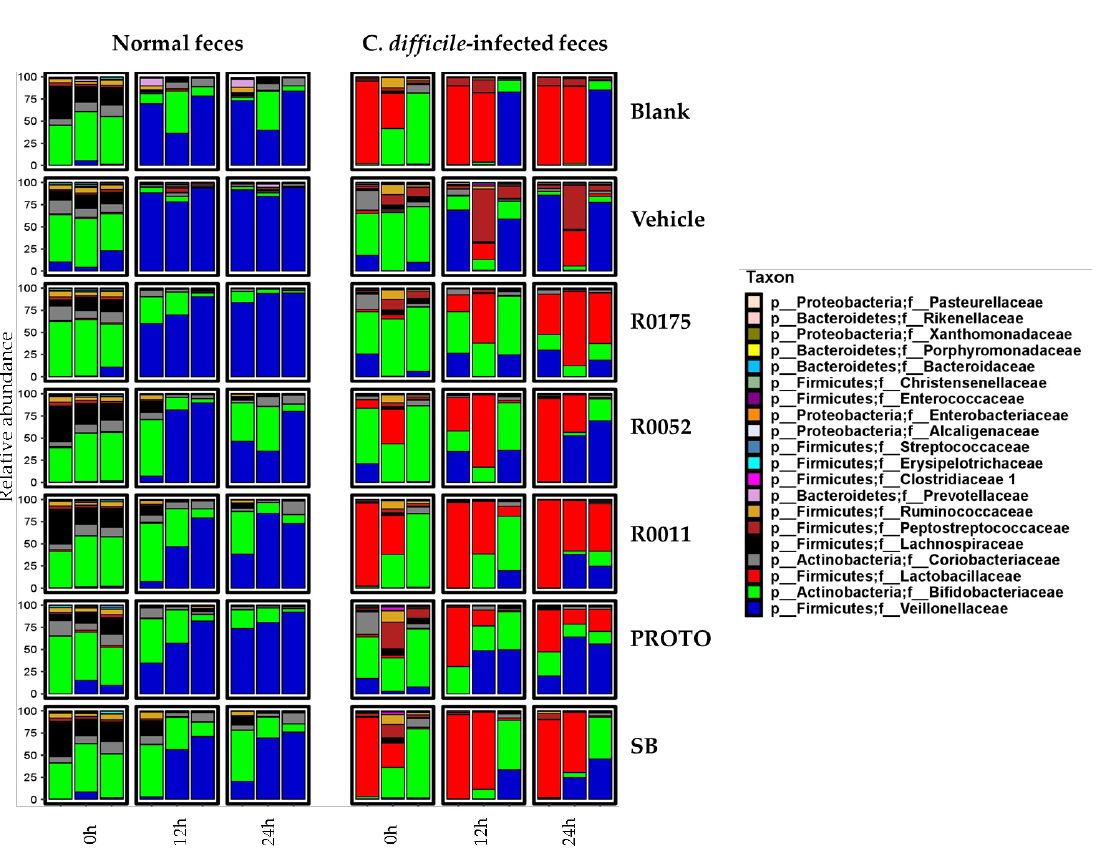
Figure 8. Taxonomic profiles (family level) of normal feces, and, Clostridium ( C. ) difficile -infected feces showing relative abundance over time. Values are shown in operational taxonomic units (OTUs). R0011 = L. rhamnosus R0011; R0052 = L. helveticus R0052; SB = S. boulardii CNCM I-1079; R0175 = B. longum R0175; PROTO = ProtecFlor TM .